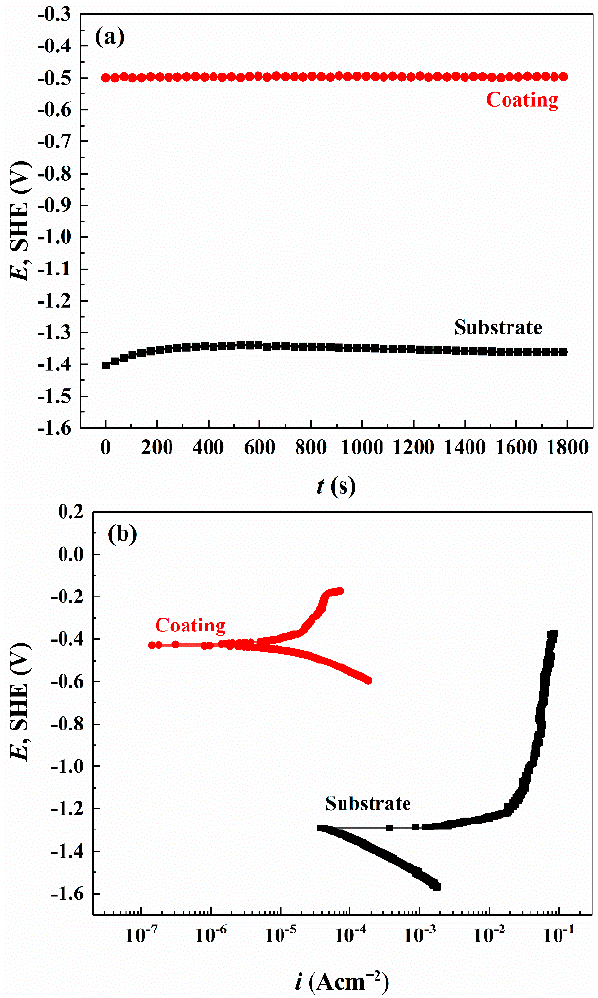
Figure 8. The open-circuit potential ( a ) and potentiodynamic polarization curves ( b ) for the substrate and coating. Table 2. Electrochemical parameters of the substrate and